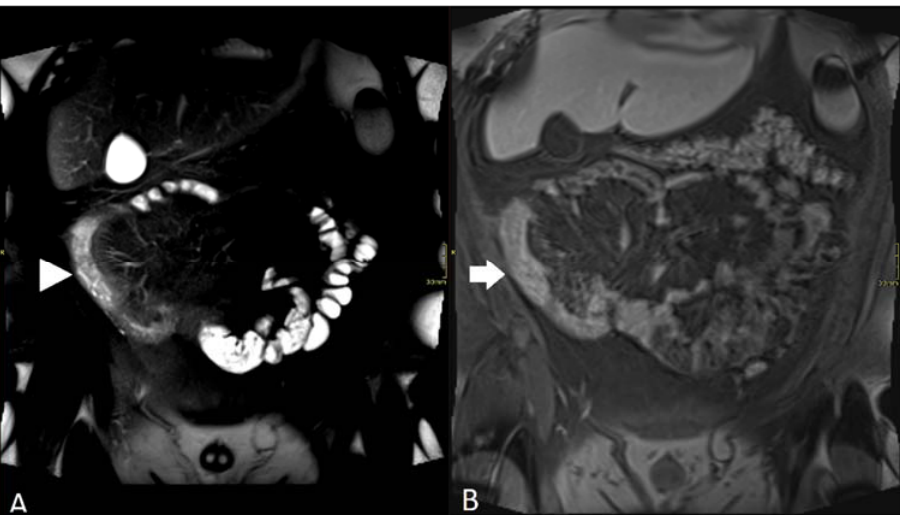
Figure 3. Sequence of a 23-year-old male with small bowel CD: ( A ) coronal fat-suppressed T2 sequence showing long segment of inflammatory disease in distal ileum (arrowhead); high T2 signal in bowel wall and adjacent fat; ( B ) coronal fat-suppressed T1 post-contrast sequence showing poor distension and marked motion artefact in distal ileum (arrow) leading to underestimation of degree of inflammation.